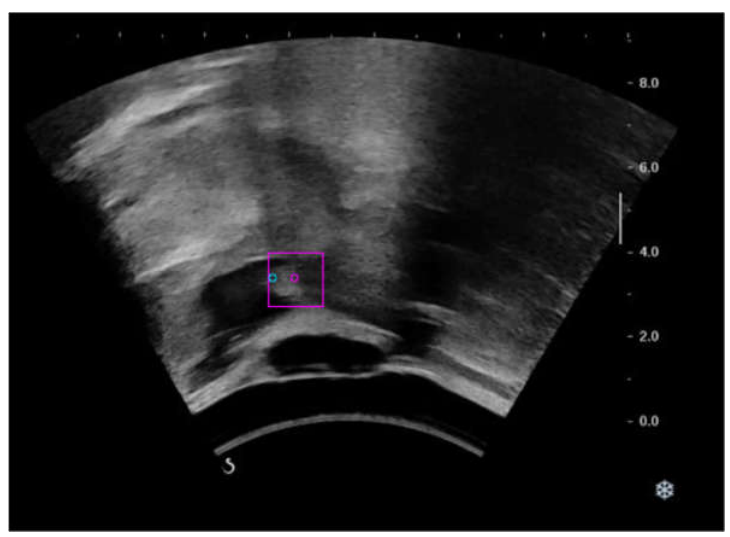
Figure 8. A frame in which two acoustic shadows of hyoid bone were seen due to fast hyoid movement speed. Ground truth location (blue dot) and prediction (pink dot with pink bounding box).